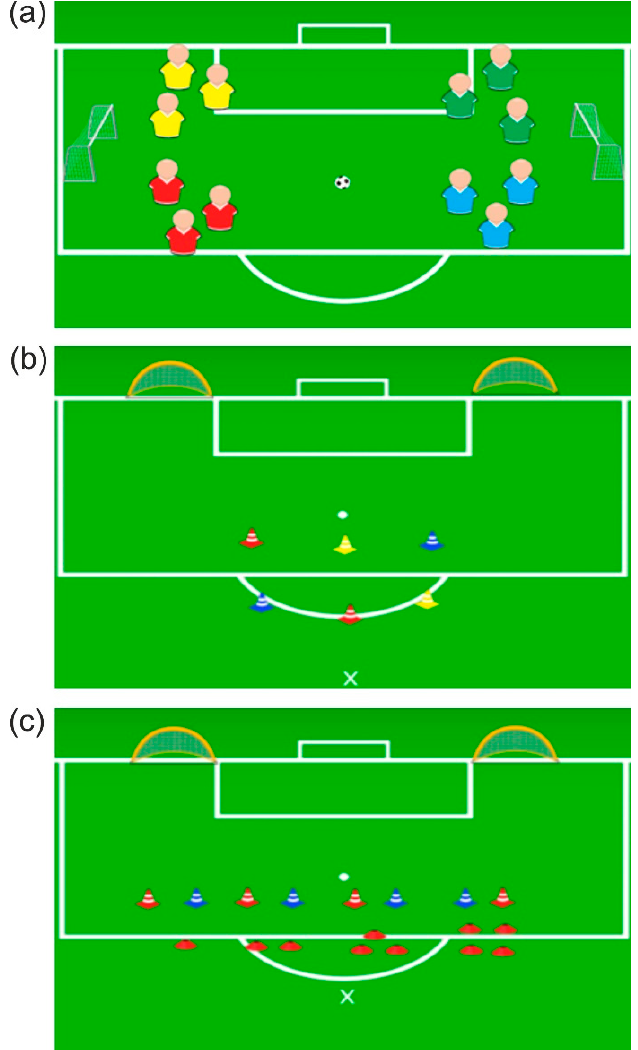
Figure 4. The other three tasks of the experimental treatment. The first ( a ) was performed twice, while the second ( b ) and third ( c ) were performed only once.